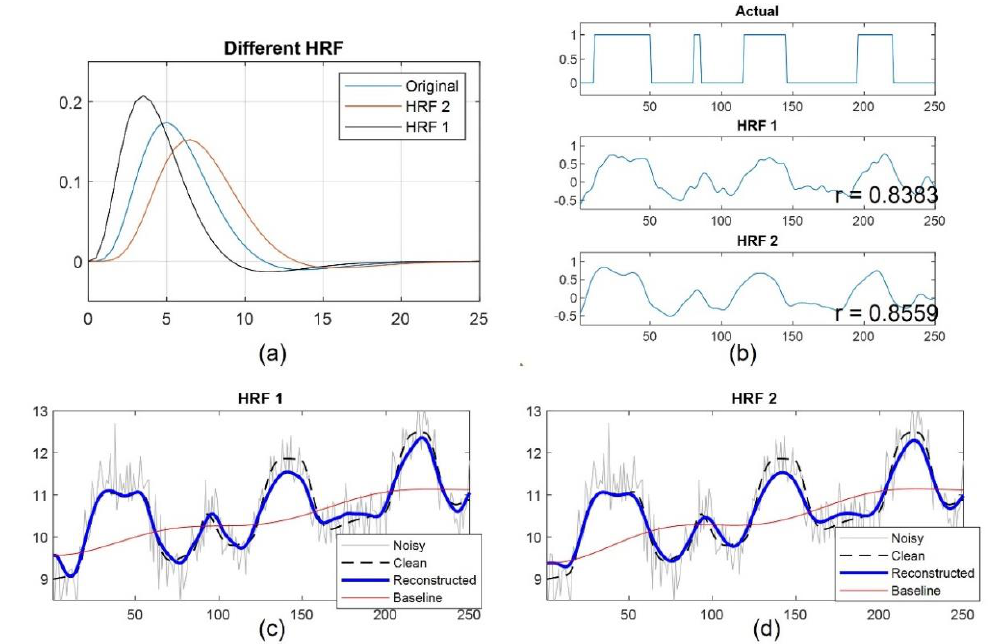
Figure A3. Checking the effect of HRF variability. ( a ) Different HRF models. ( b ) The estimated pseudo-stimulus using different HRF models. The correlation between the pseudo-stimulus and the actual experiment design is also shown in the subplot. ( c , d ) Original and reconstructed time series obtained using different HRF models.